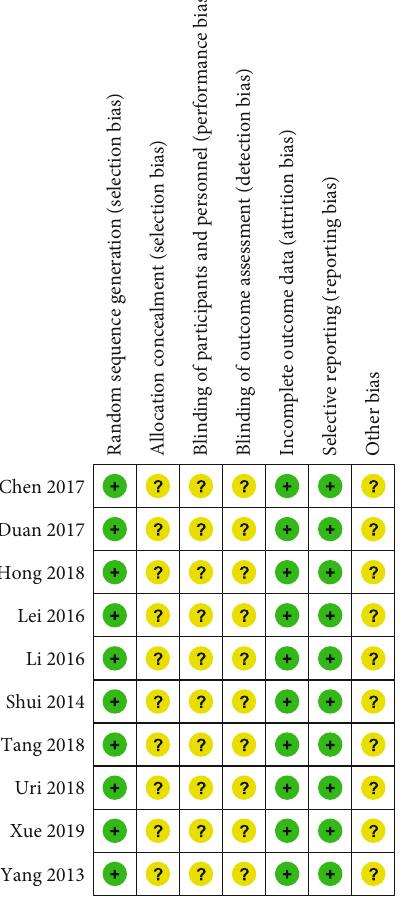
Figure 2: Risk of bias summary. +: low risk of bias; − : high risk of bias; ?: bias